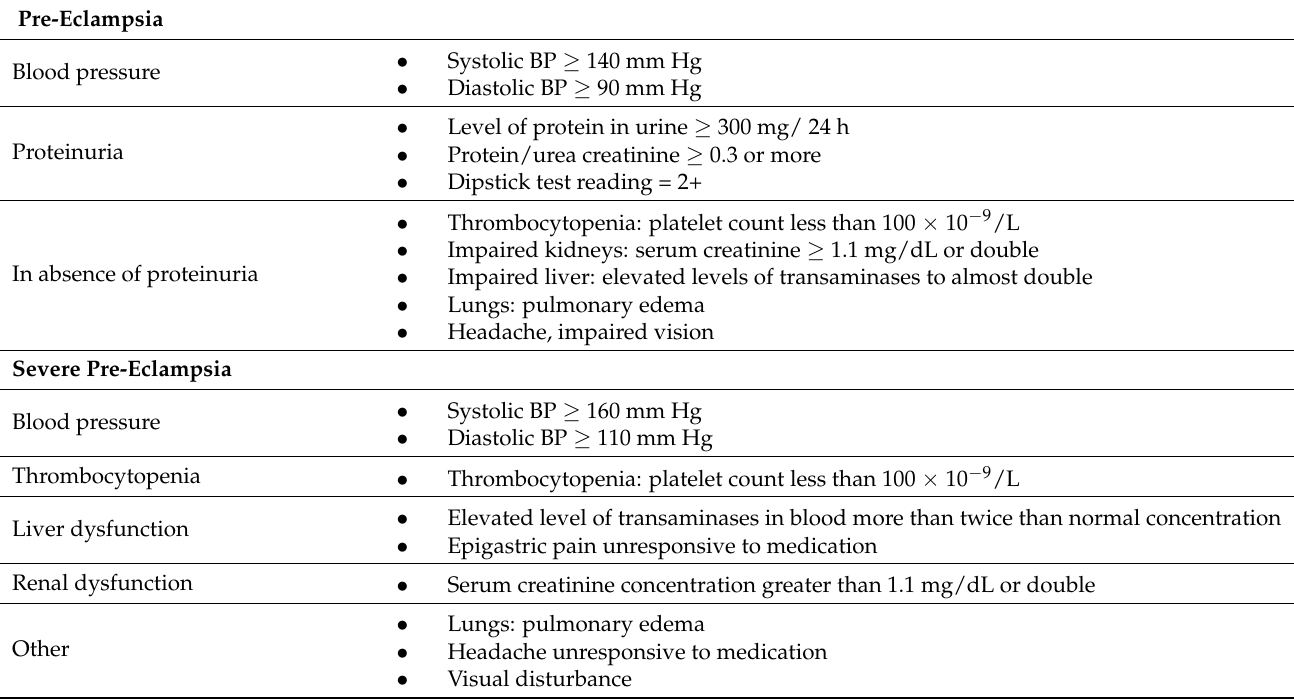
Table 1. Pre-eclampsia biomarkers according to